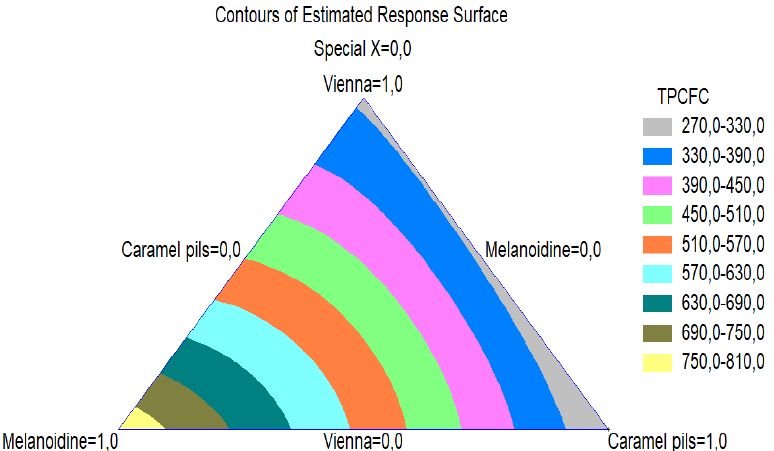
Figure 4. Effect of mixture composition on the TPC, measured by FC method. (the “,” character represents a decimal point).